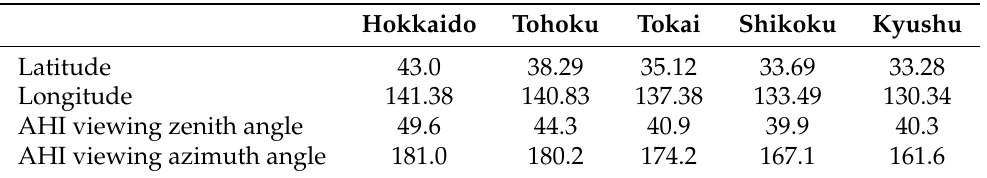
Figure 4. ( a ) Location of Japan and the centers of the five test sites. Contour lines in the left panel depict the viewing zenith angle of AHI; ( b ) the Hokkaido site, where the ROIs are depicted by dotted lines; ( c ) the Tohoku site; ( d ) the Tokai site; ( e ) the Shikoku site; ( f ) the Kyushu site; and ( g ) the averages of land cover percentage in the ROIs for each site, as created on the basis of the MODIS land cover products. Table 1. Geographic coordinates of each site center, and the AHI viewing angles for each coordinate in decimal degrees